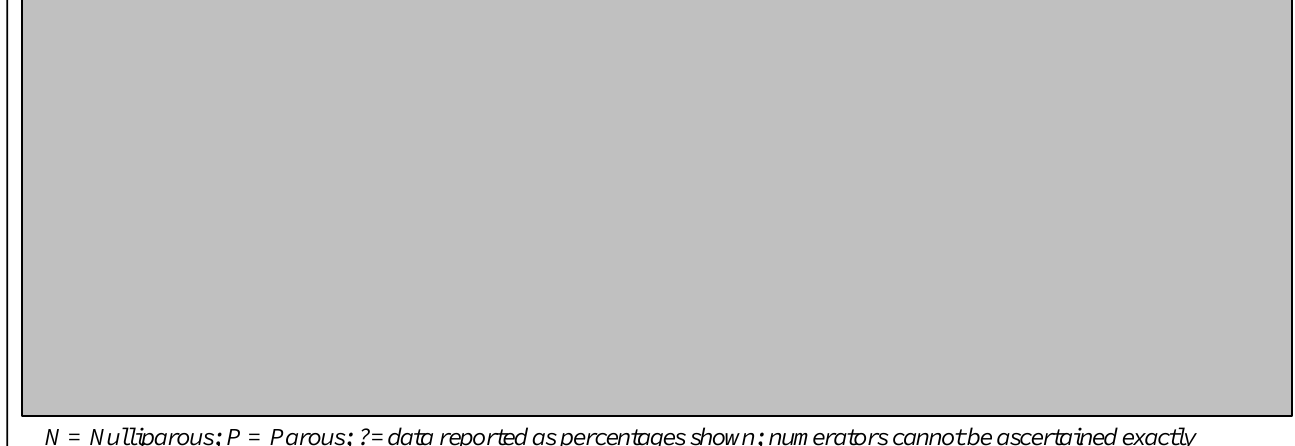
Table I : Episiotomies and third-degree lacerations in five randomized controlled trials